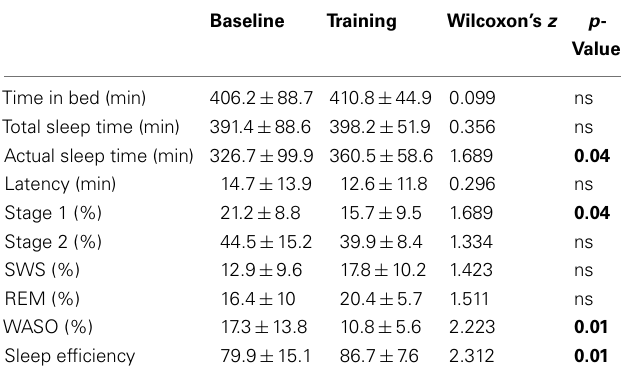
Table 2 | Sleep fragmentation in different sleep stages.